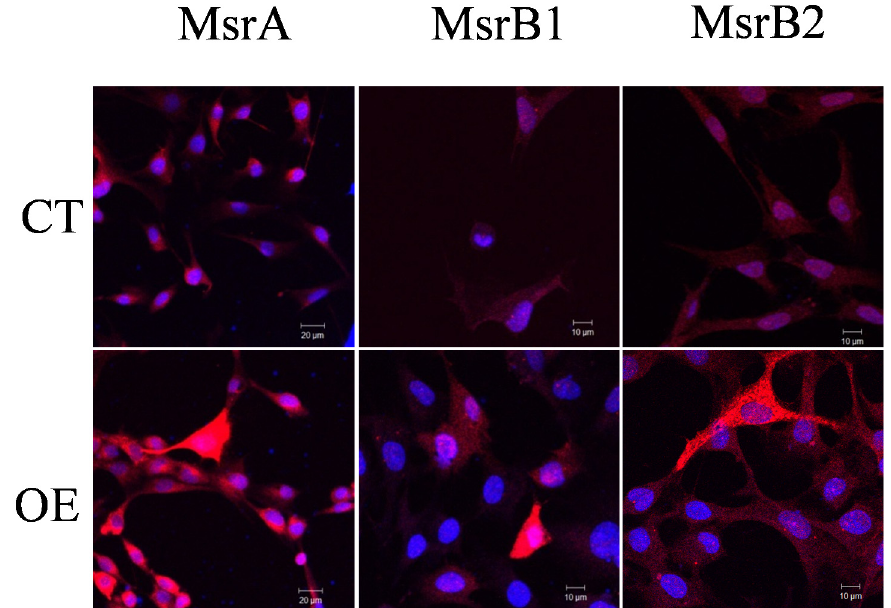
Figure A1. Msr over-expression in cultured rat pancreatic stellate cells. Pancreatic stellate cells were transfected with adenovirus vectors and immunocytochemistry was performed as described in Figure 2E. The primary anti-MsrA, B1, 2 antibodies and TRITC labeled donkey anti-rabbit secondary antibody were used. Nucleus was counter-stained with Hoechst 33342. Imaging was done in a Zeiss LSM 510 META (objective 63×/1.40 oil) with λ ex : TRITC/543 nm, Hoechst 33342/405 nm. No fluorescence was observed in time-matched control experiments (without primary and secondary antibodies, without primary antibody but with secondary antibody, non-specific rabbit IgG as primary antibody plus secondary antibody, not shown). The laser power for fluorescent excitation was set as in Figure 1E, F but not tuned down as in Figure 2E even for the Msr-overexpressing (OE) pancreatic stellate cells. Note the over-exposed staining pattern in Msr overexpressing (OE) rat pancreatic stellate cells, Msr staining was normal in control pancreatic stellate cells (CT) not overexpressing Msr. The scale bars are 20 for MsrA, 10 μ m for MsrB1, B2 respectively.